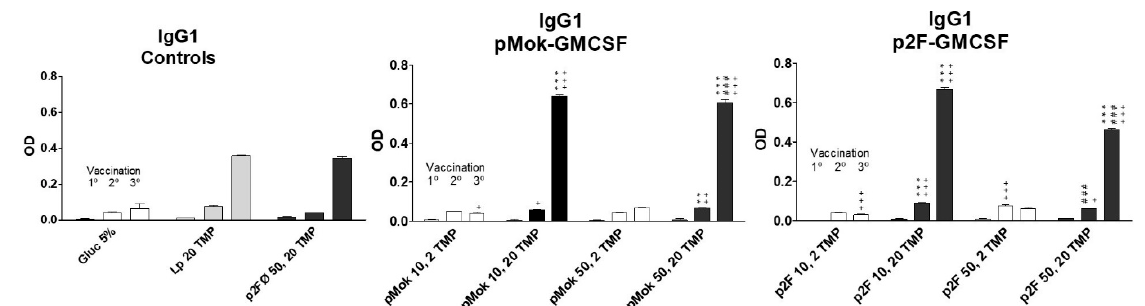
Figure 5. IgG1 response obtained after each vaccination dose in the different formulations of multicompartmental lipopolyplex loaded with a water-soluble protein extract (TMP). Lipolyplexes contained 10 or 50 µg of plasmid (pMok or p2F) bearing murine GM-CSF gene and 2 or 20 µg of TMP. * symbol is employed to define the statistically significant difference due to the amount, 2 or 20 µg, of TMP (** p < 0.01; *** p < 0.001) in each vaccination. # symbol indicates the statistical significance due to the amount, 10 or 50 µg, of GM-CSF (### p < 0.001) in each vaccination. + symbol is employed to define the statistically significant difference with respect to Glucose 5% control group. ( + p < 0.05; + + p < 0.01; + + + p < 0.001) in each vaccination.